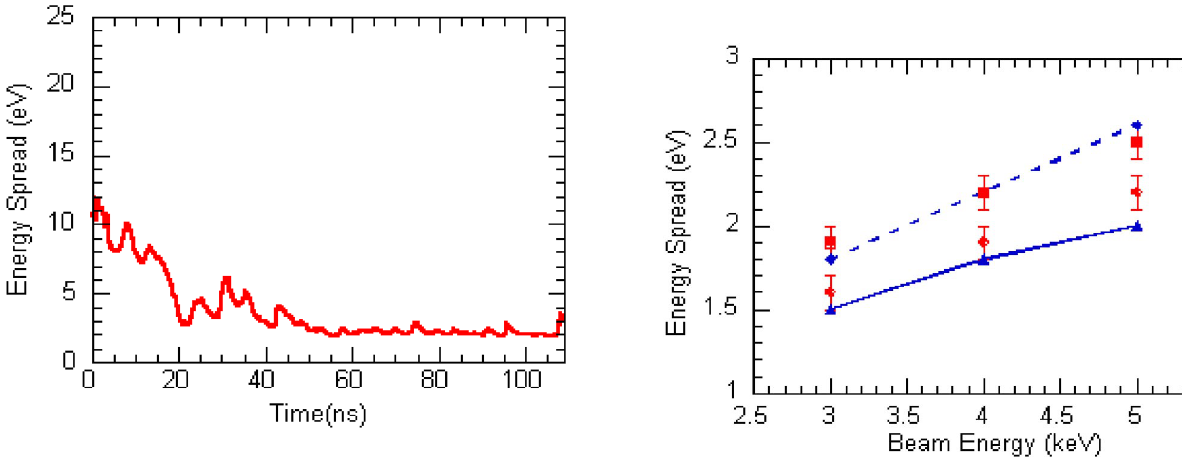
FIG. 11. (Color) Measured beam energy spreads compared with the theoretical predictions for different beam